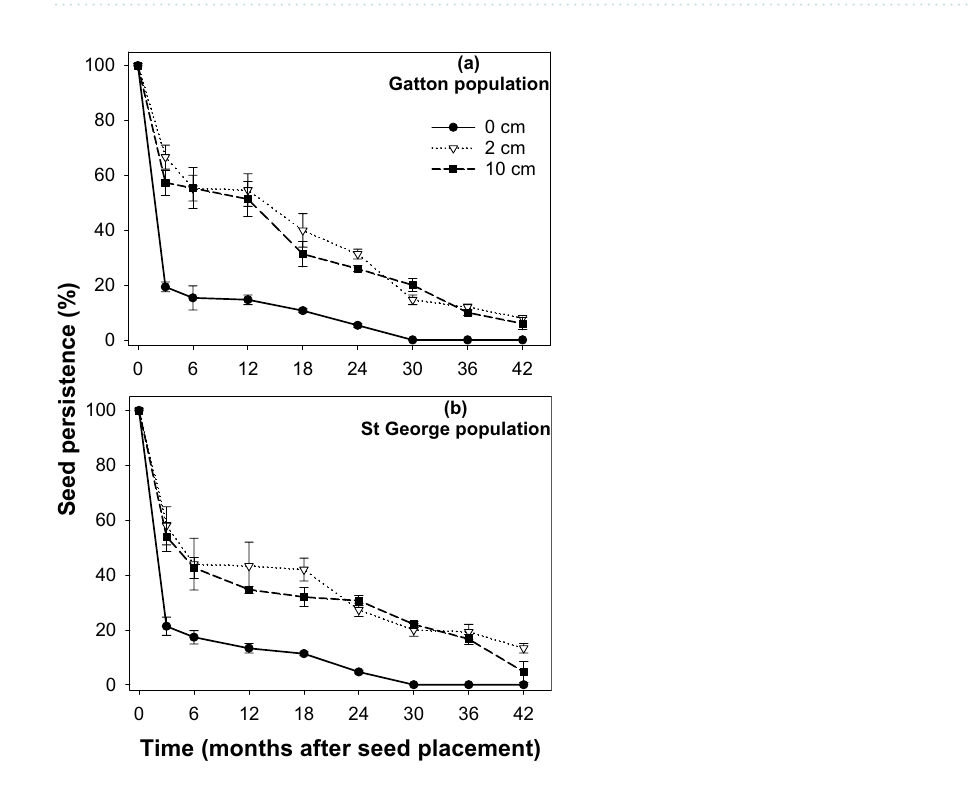
Figure 5. Seed persistence of Rapistrum rugosum from Gatton ( a ) and St George ( b ) locations placed in mesh- bags at 0, 2, and 10 cm depths, symbols correspond to mean and error bars are the standard error of means (n =